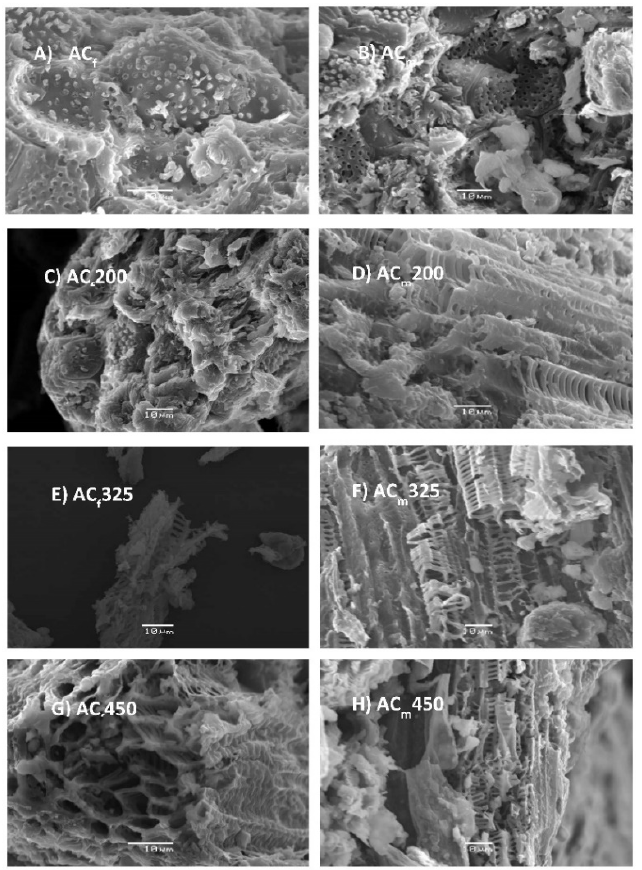
Figure 4. SEM of the A. aculeata and its biochars. ( A , B ) show the natural endocarp, ( C , D ) correspond to biochar at 200 °C, ( E , F ) to biochar at 325 °C and ( G , H ) to biochar at 450 °C. The left column corresponds to the fine samples and the right column to the medium granulometry.